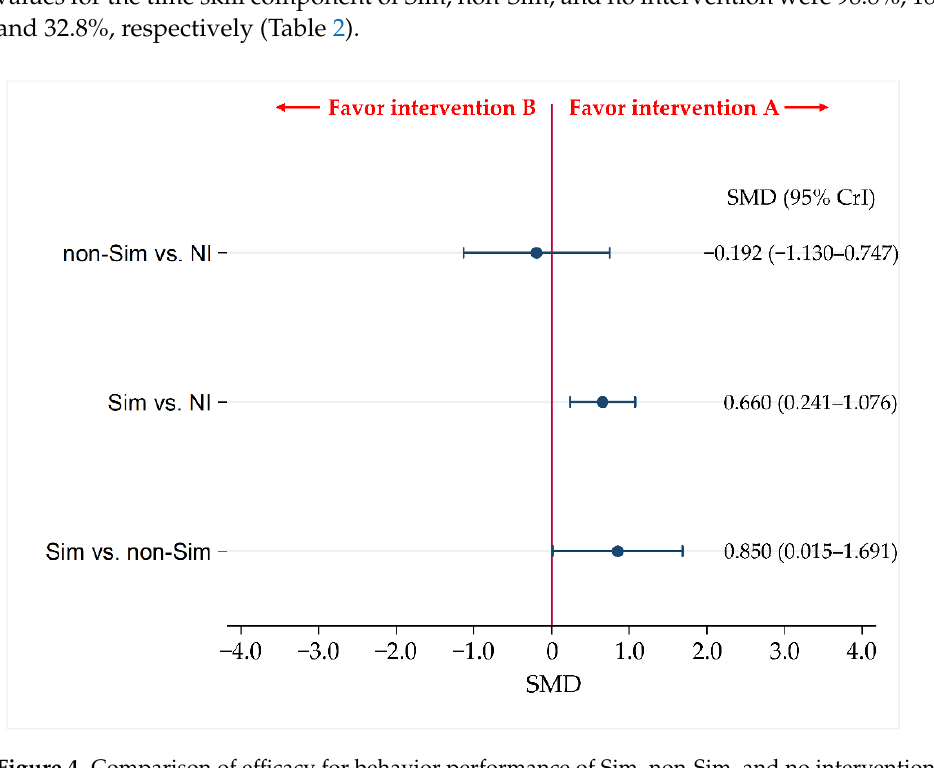
Figure 4. Comparison of efficacy for behavior performance of Sim, non-Sim, and no intervention. We expressed the comparisons as intervention A vs. intervention B. Data were expressed as standardized mean differences (Std. MD) and 95% credible intervals (CrIs). Sim, simulation-based training; non-Sim, non-simulation-based training; NI, no intervention. Table 2. Surface under the cumulative ranking (SUCRA) curve values and ranking of efficacy for behavior performance.